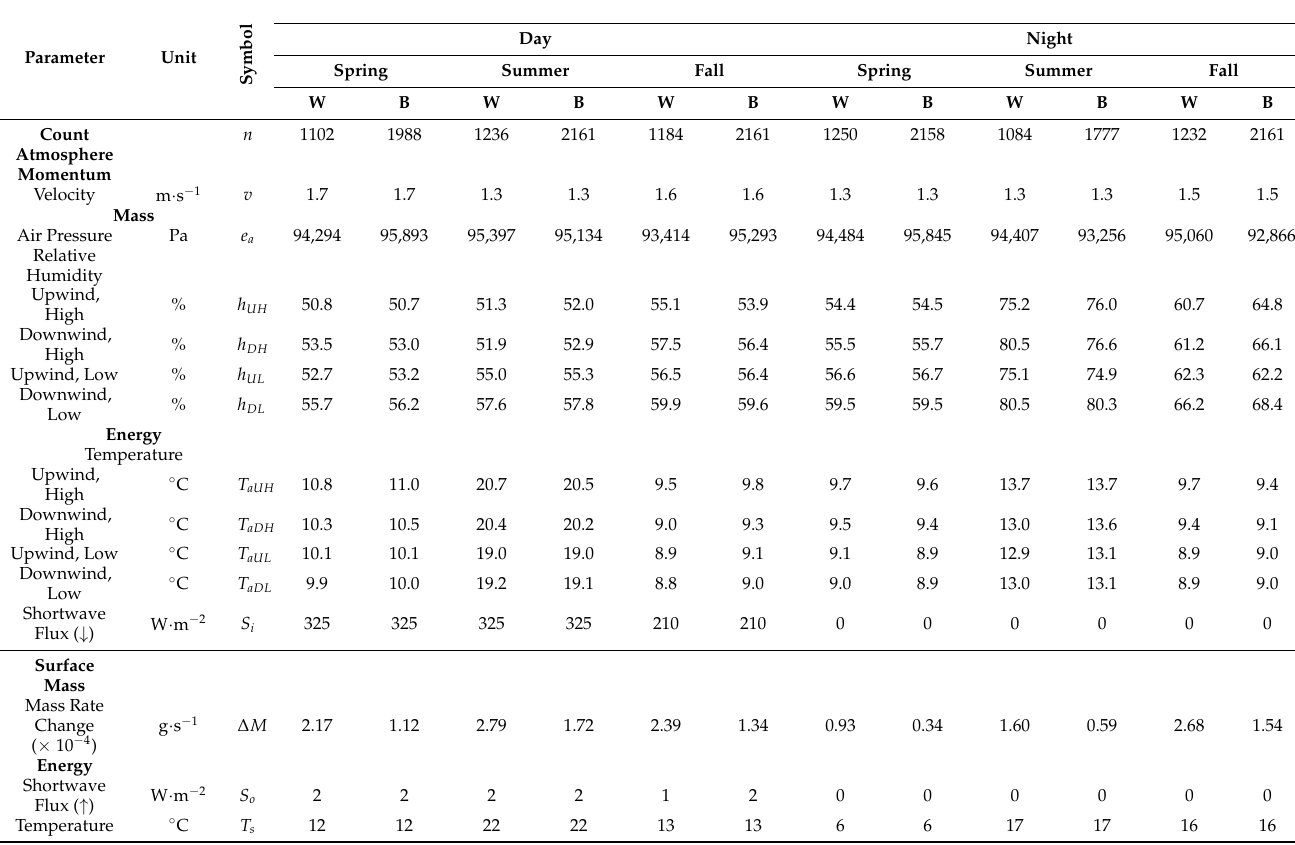
Table 2. Summary of the measured average atmospheric and surface